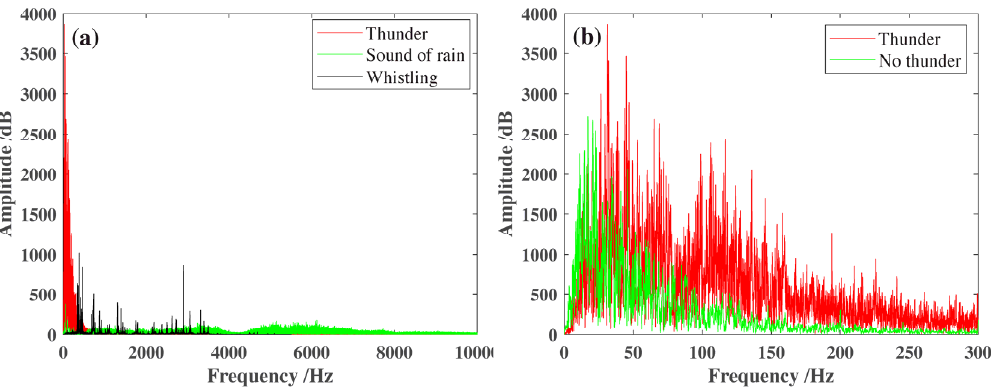
Figure 5. ( a ) Spectral comparison of thunder and typical noise; and ( b ) spectral comparison of environmental signals with and without thunder.